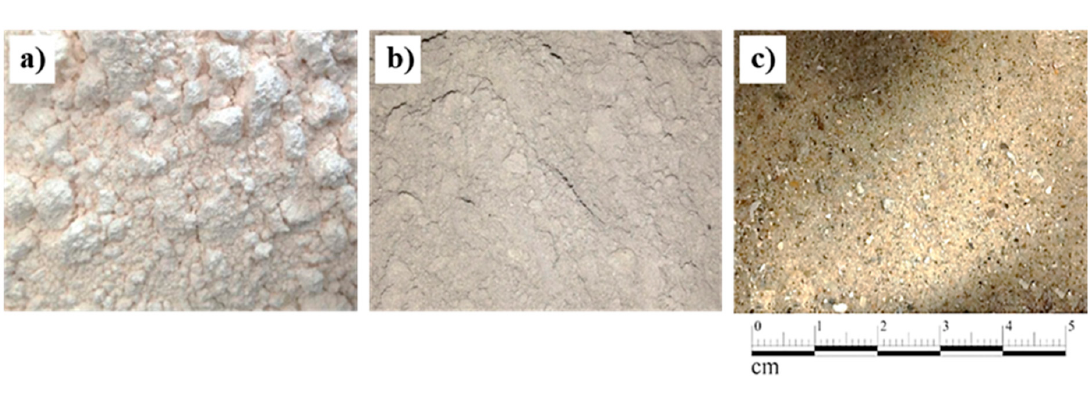
Figure 1. Visual aspect of ( a ) metakaolin, ( b ) biomass ash, and ( c ) river sand. Table 2. Mineralogical composition (wt%) of kaolin measured by XRD. Table 1. Chemical composition (wt%) of kaolin and biomass ash measured by X-ray fluorescence Table 2. Mineralogical composition (wt%) of kaolin measured by XRD. (XRF).